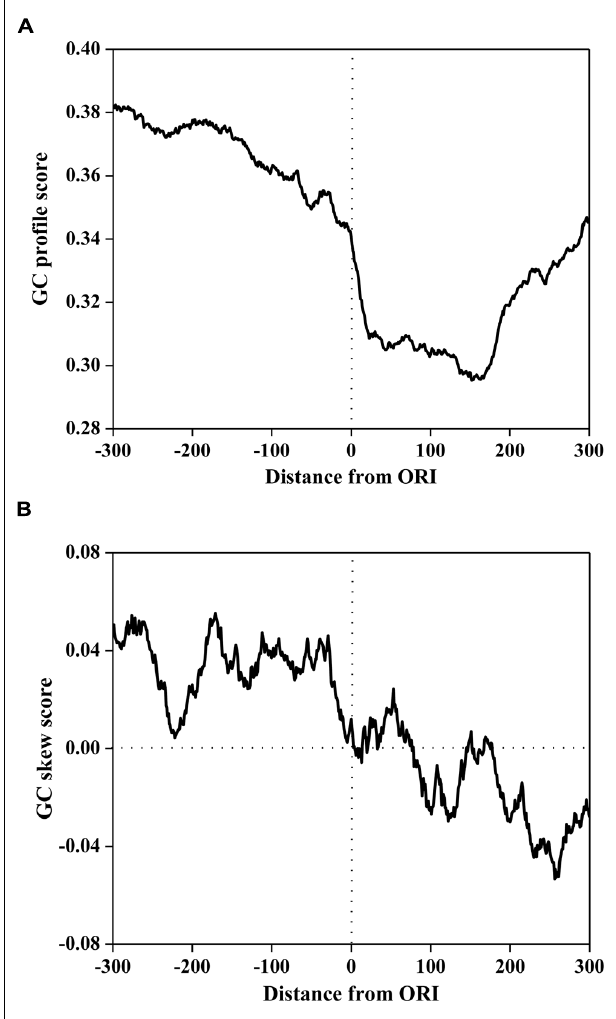
FIGURE 1 |The GC profile (A) and the GC skew (B) of origins of replication (in ORIs) and surrounding regions. The profiles are plotted using a 50-bp sliding window with a 1-bp step.The horizontal axis represents the nucleotide position, which ranges from − 300 to + 300 bp relative to ORIs (denoted as 0).The vertical axis represents the GC content score (A) and GC skew score (B) .